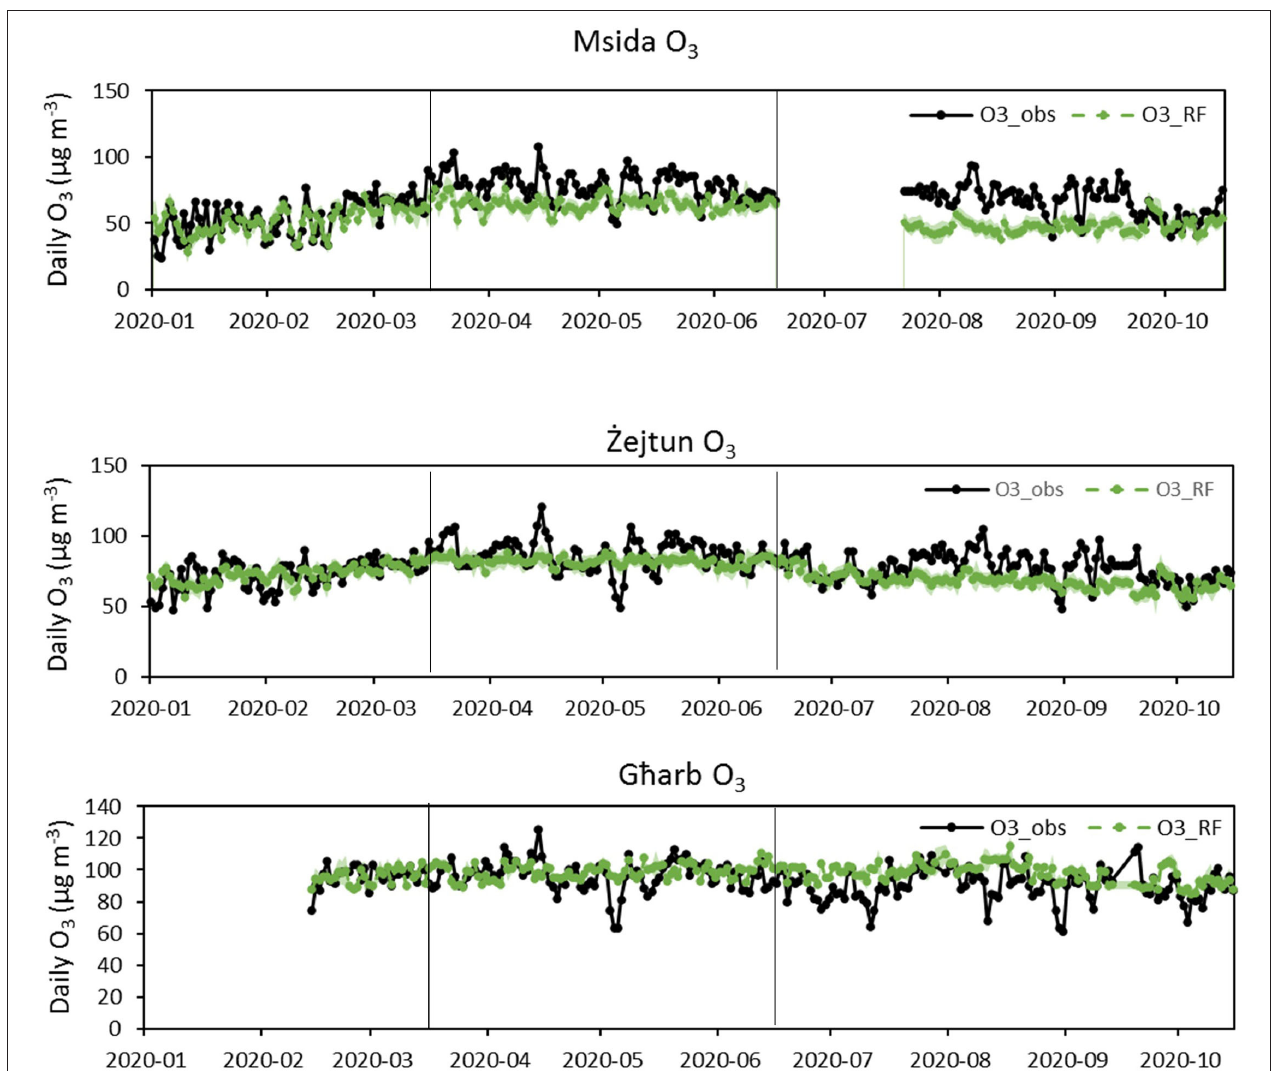
FIGURE 5 | Daily predicted (green) and measured (black) O 3 concentrations at Msida, ˙Zejtun and G è arb between the 1st January and 15th October 2020. Shaded green area indicates the 95% confidence interval of the O 3 predictions. Vertical lines indicate the closure of schools on the 11th March and the end of the public